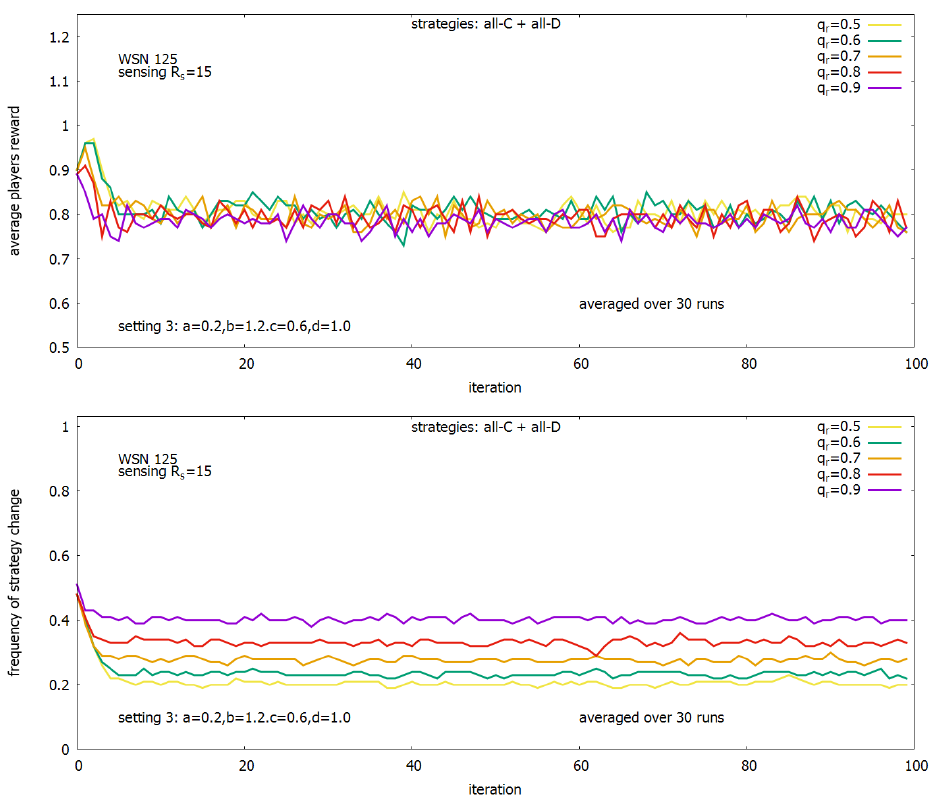
Figure 13. Solutions generated under setting 3 for a range of q r : average agents rewards ( upper ) and corresponding frequency of strategy changing ( lower